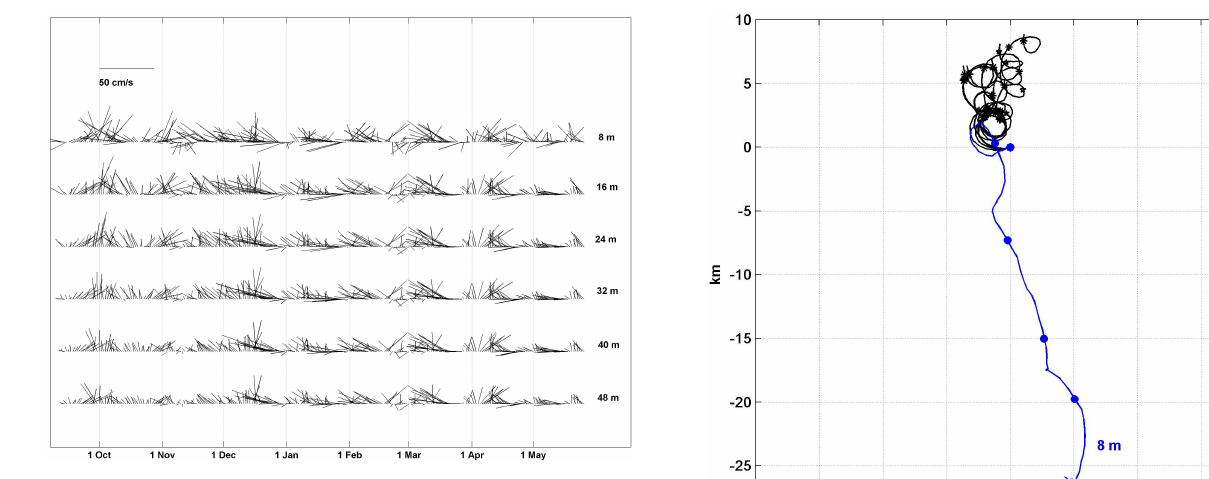
Fig. 7. Stick Diagram of daily mean data of horizontal currents from the ADCP at each level.